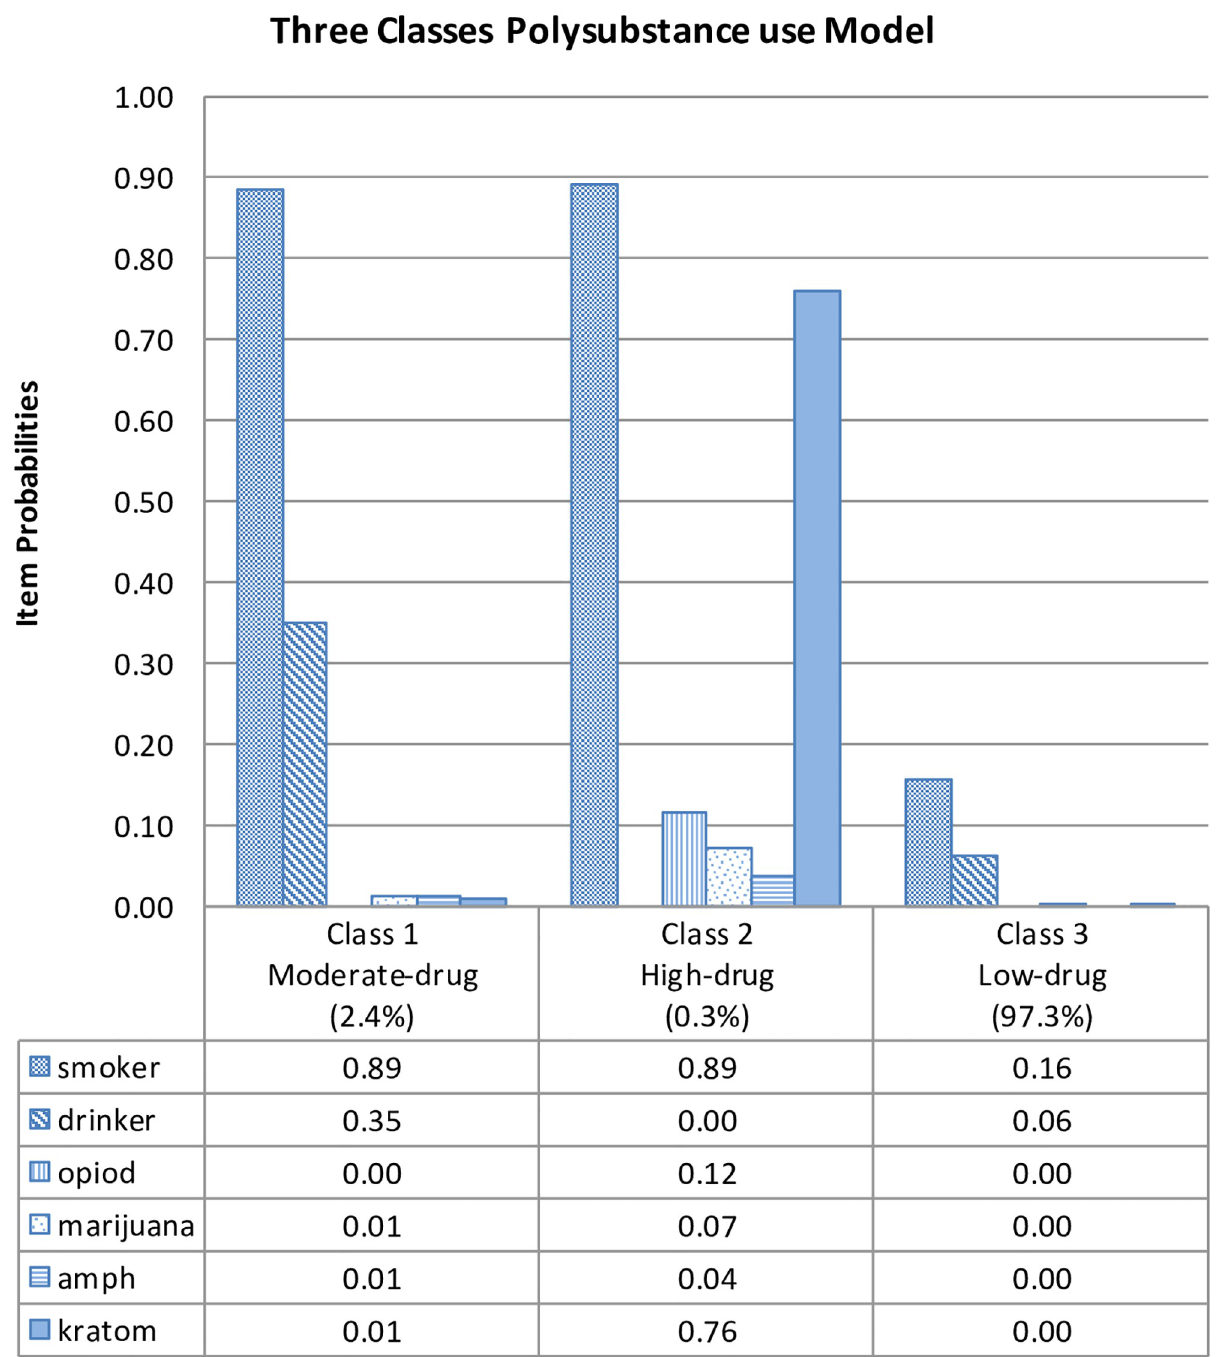
Fig 2. Probabilities of substance use indicators in each class in the three-class